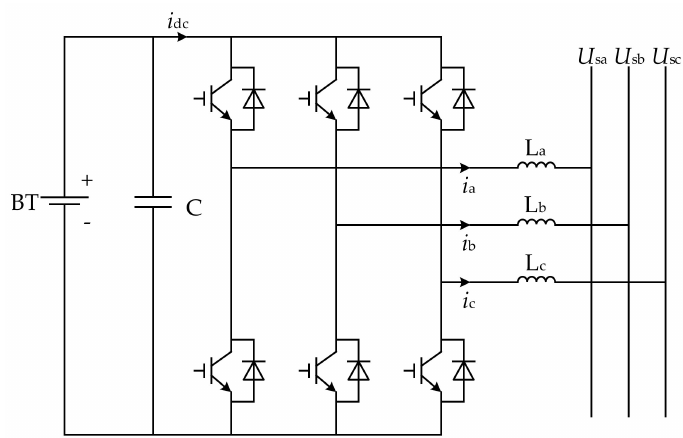
Figure 3. Main circuit structure of second-use energy storage system